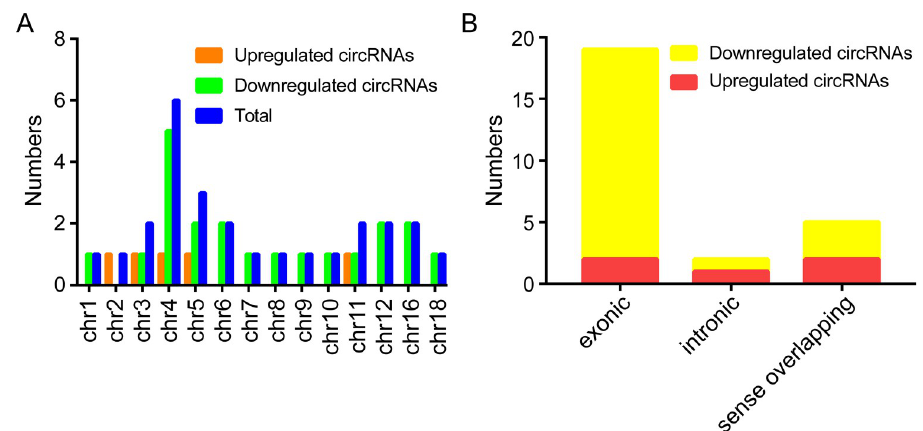
Fig 3. Characteristics of altered circRNAs between CIH and control samples. (A) The cluster shaped bar diagram shows the chromosome distribution of dysregulated circRNAs. (B) The histogram shows the origination of circRNAs.